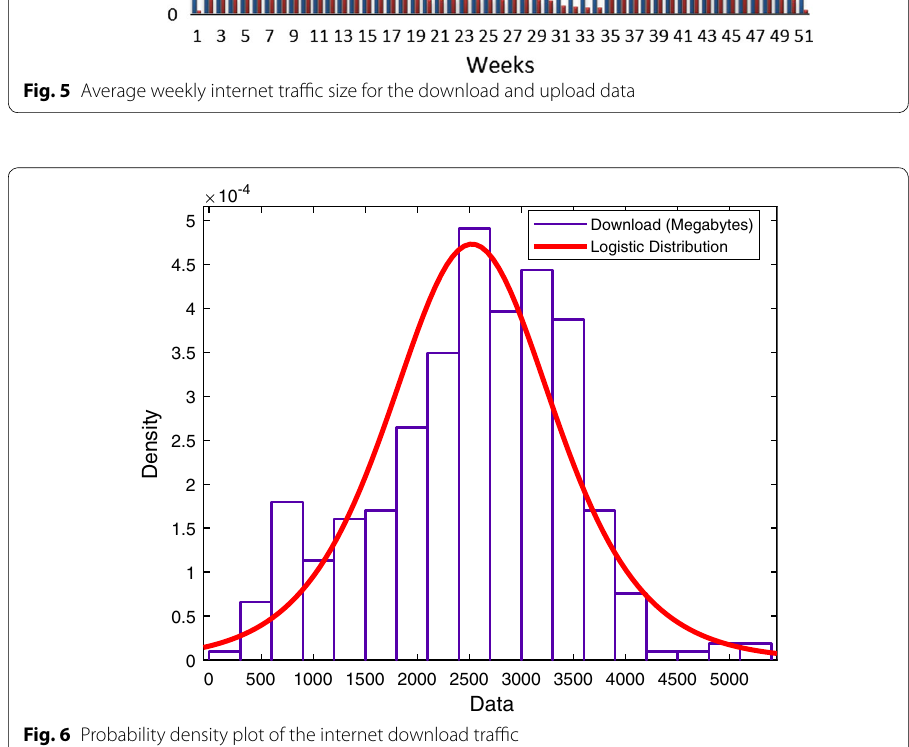
Fig. 6 Probability density plot of the internet download